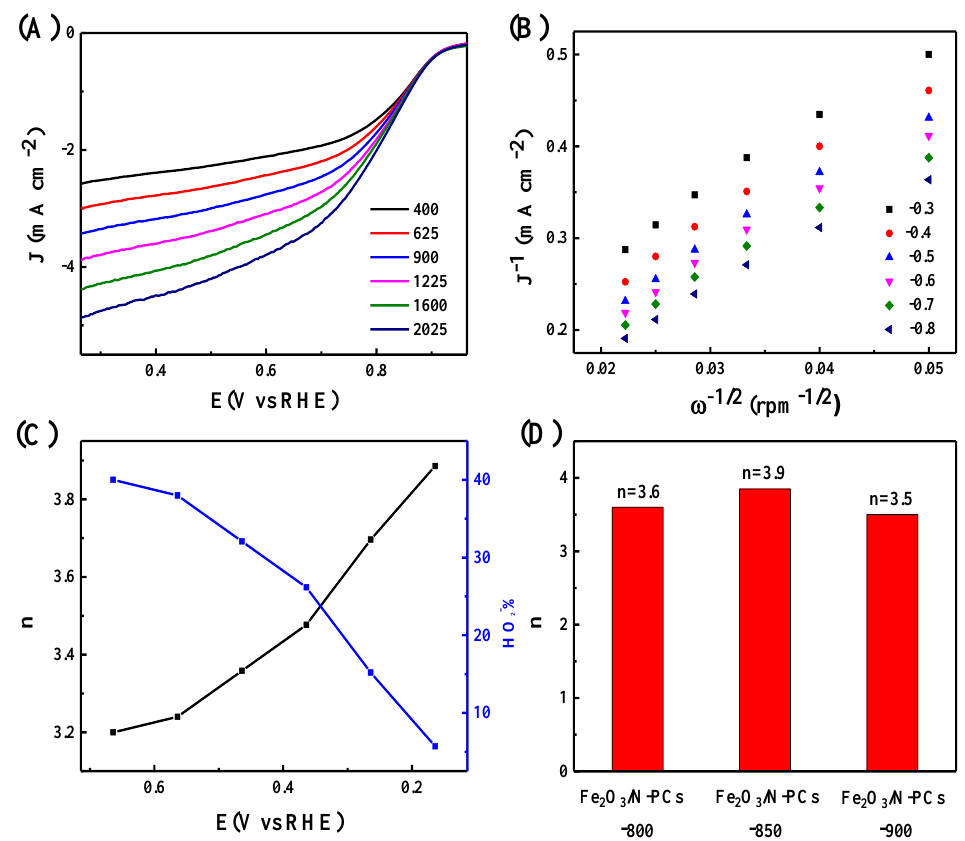
Figure 7. The data derived from the RDE measurements. ( A ) The LSV curves of ORR for Fe 2 O 3 /N-PCs-850/GC at different rotation speeds; ( B ) K-L plots at different potentials of Fe 2 O 3 /N-PCs-850 in 0.1 M KOH at a scan rate of 5 mV·s −1 ; ( C ) HO 2− yields and the electron transfer number during the ORR process of Fe 2 O 3 /N-PCs-850/GC; ( D ) The transferred electron numbers of the designed catalysts calculated from RDE. Table 1. ORR catalytic performances comparison of electrocatalysts derived from biomass materials.